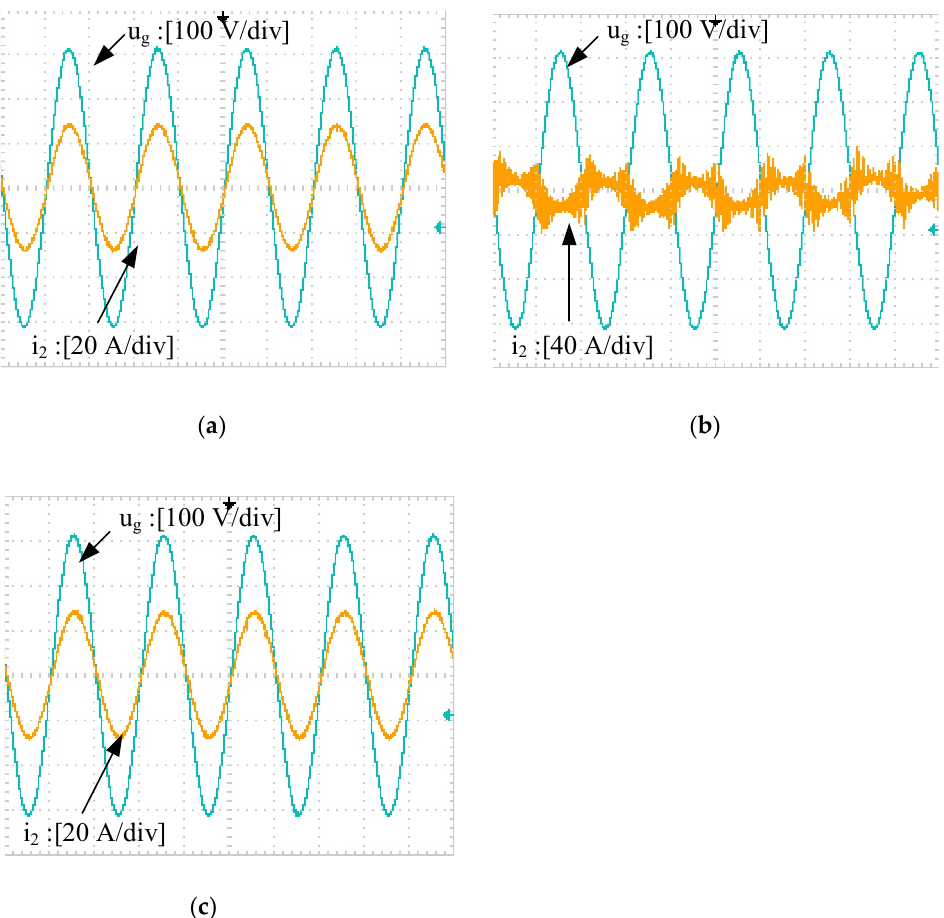
Figure 19. Experimental results: ( a ) FOGCI with capacitor current proportional feedback, where α + β = 2 ( α = 1.2, β = 0.8); ( b ) FOGCI without capacitor current proportional feedback, where α + β = 2 ( α = 1.2, β = 0.8); ( c ) FOGCI without capacitor current proportional feedback, where 𝛼 + 𝛽 = 2 (α = 0.8 , β = 0.8).